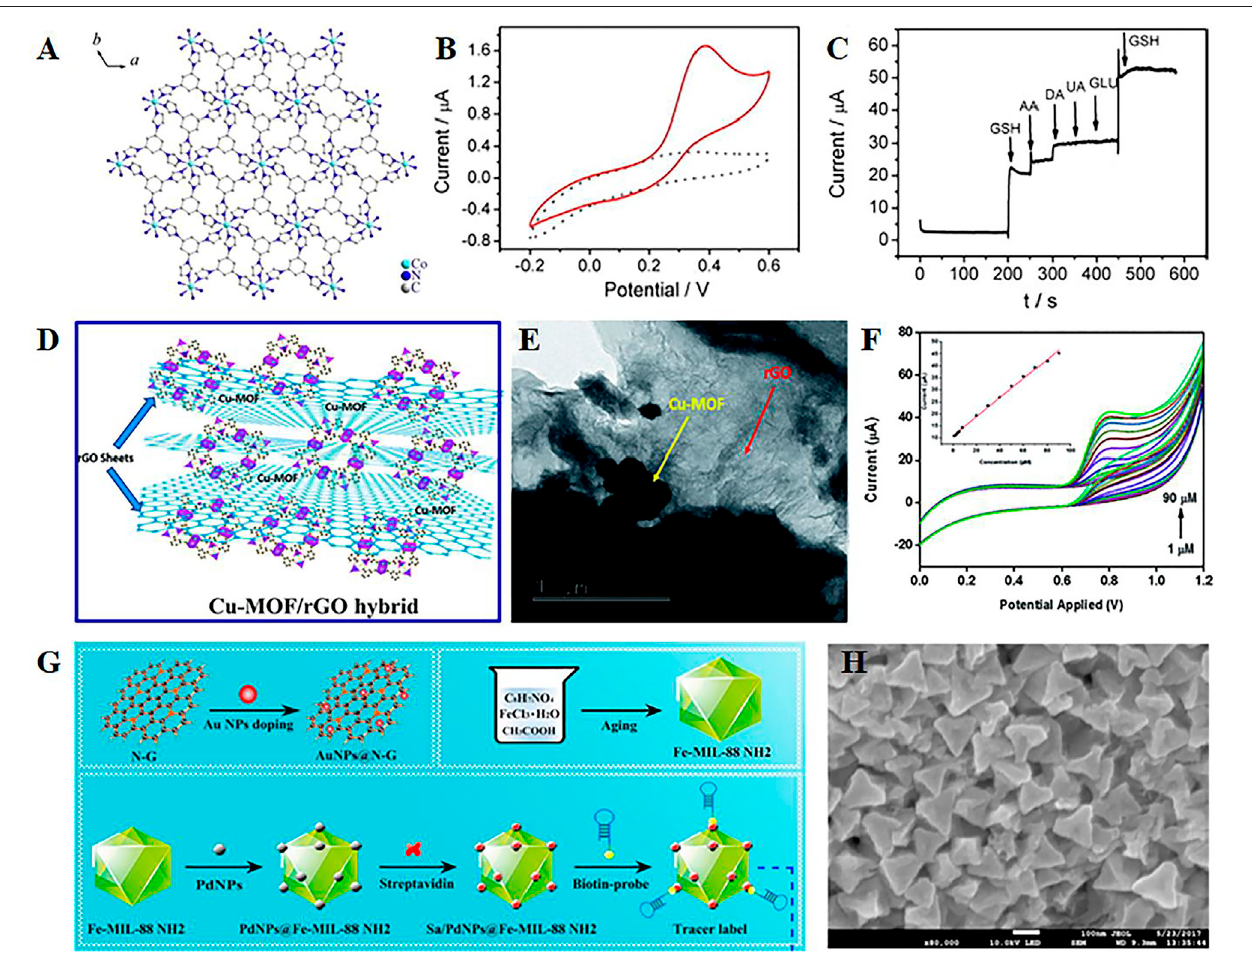
FIGURE 2 | (A) Illustration of the structure of metal – organic coordination polymers with 1,3,5-tris (1-imidazolyl) benzene and transition element Co 2+ (Co-MOCP), CVs (B) , and interference test (C) of the Co-MOCP/carbon paste electrode in the different solution. Reproduced with permission (Yuan et al., 2014). Copyright 2014, Elsevier. Schematic structure (D) , transmission electron microscope (TEM) images (E) , and CV curves at different nitrite concentrations (F) of the Cu-MOF/rGO hybrid. Reproduced with permission (Saraf et al., 2016). Copyright 2016, RSC. (G) Synthetic route of different composites; (H) fi eld emission scanning electron microscope image of PdNPs@Fe-MOFs. Reproduced with permission (Li et al., 2018). Copyright 2018,